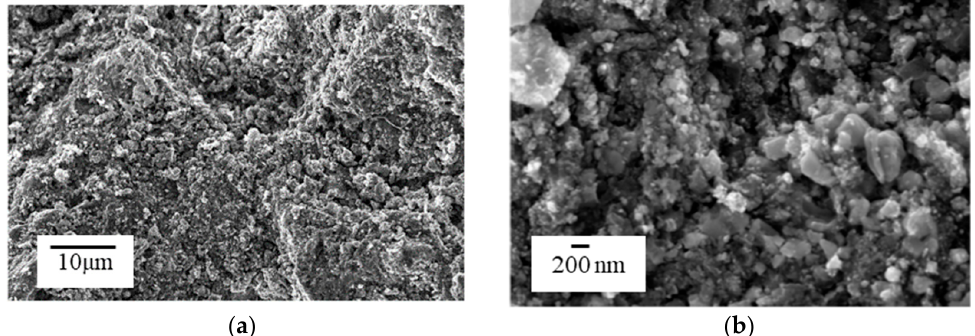
Figure 7. FESEM image of the biochar filler: ( a ) overview at magnification of 10 m; ( b ) magnification of 200 nm showing the granular aspect of biochar.